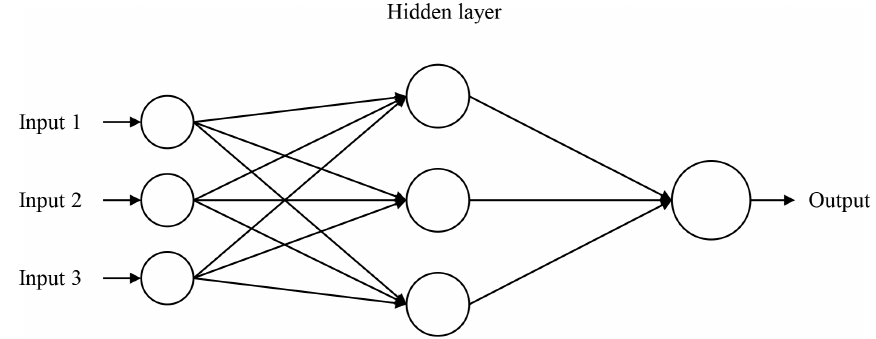
Figure 5. Typical ANN